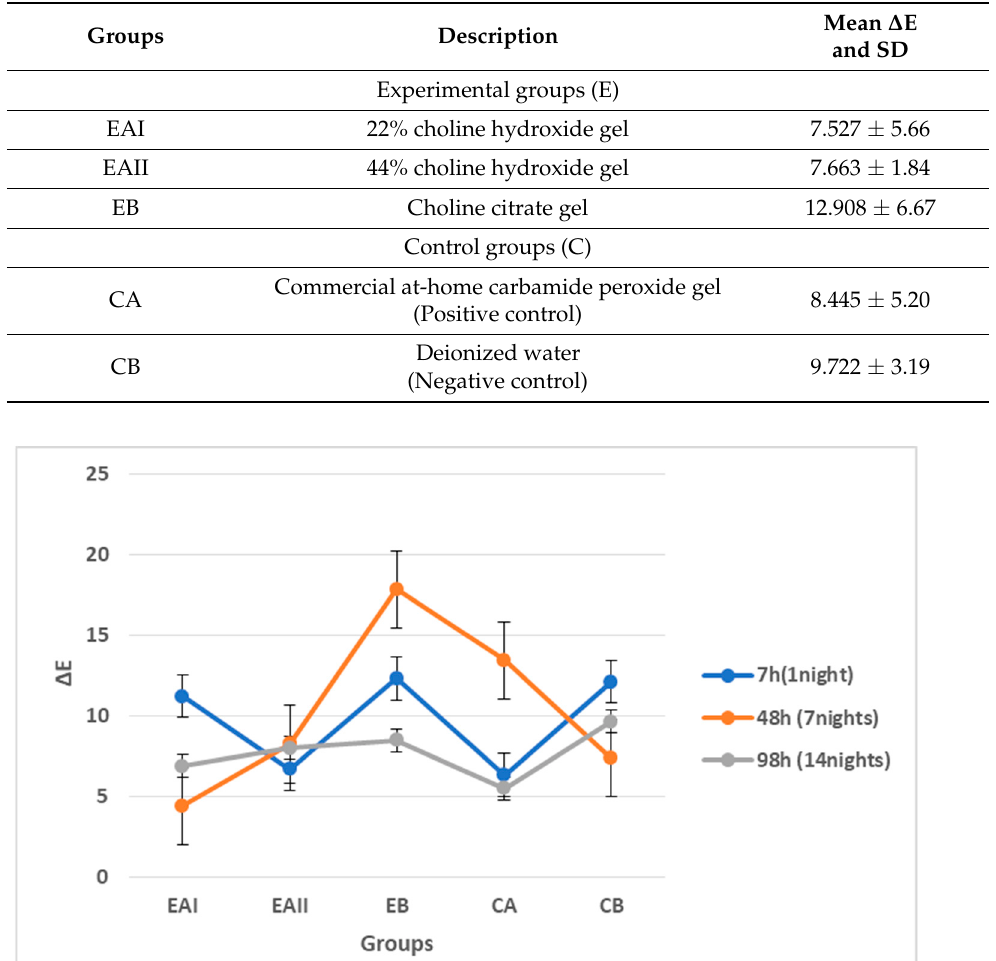
Figure 5. Trend of Δ E for the treatment duration across fi ve groups. At 7 h, EAI, EB, and CB showed Figure 5. Trend of ∆ E for the treatment duration across five groups. At 7 h, EAI, EB, and CB showed Δ E values in the same range, i.e., Δ E > 10 with EAII and CA, showing Δ E values in the same range, ∆ E values in the same range, i.e., ∆ E > 10 with EAII and CA, showing ∆ E values in the same range, i.e., Δ E < 10. At 49 h, EB and CA showed Δ E values in the same range, i.e., Δ E > 10, with EAI, EAII, i.e., ∆ E < 10. At 49 h, EB and CA showed ∆ E values in the same range, i.e., ∆ E > 10, with EAI, EAII, and CB showing Δ E values in the same range, i.e., Δ E < 10. At 98 h, all the fi ve groups showed Δ E and CB showing ∆ E values in the same range, i.e., ∆ E < 10. At 98 h, all the five groups showed ∆ E values in the same range, i.e., Δ E < 10. values in the same range, i.e., ∆ E <